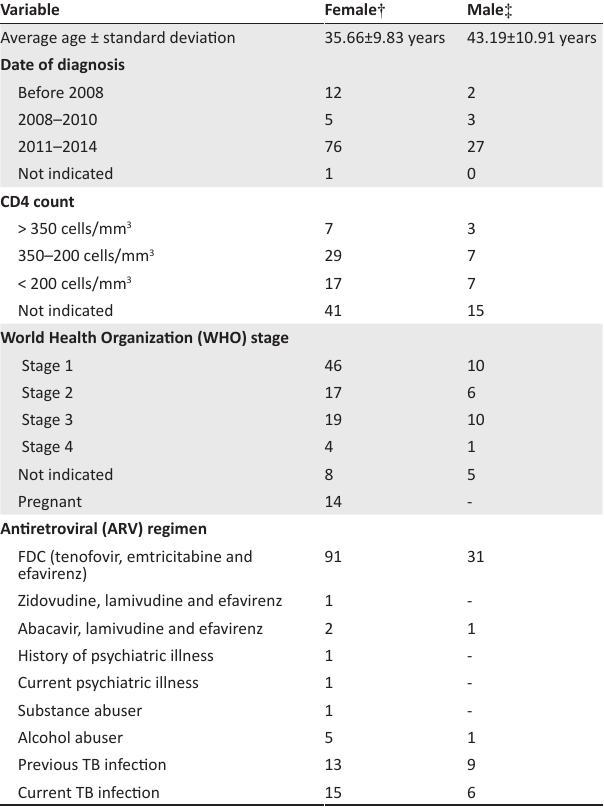
TABLE 1: Baseline data of